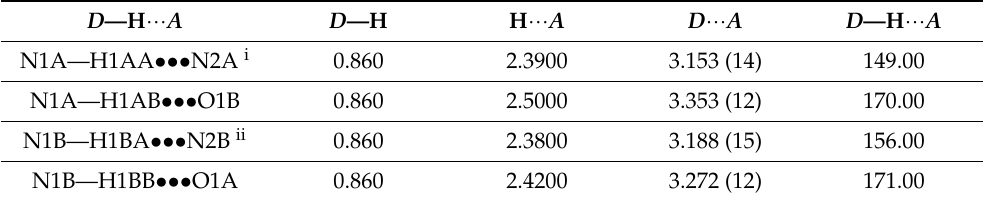
Table 2. Hydrogen-bond geometry (Å, ◦ ) for compound 4